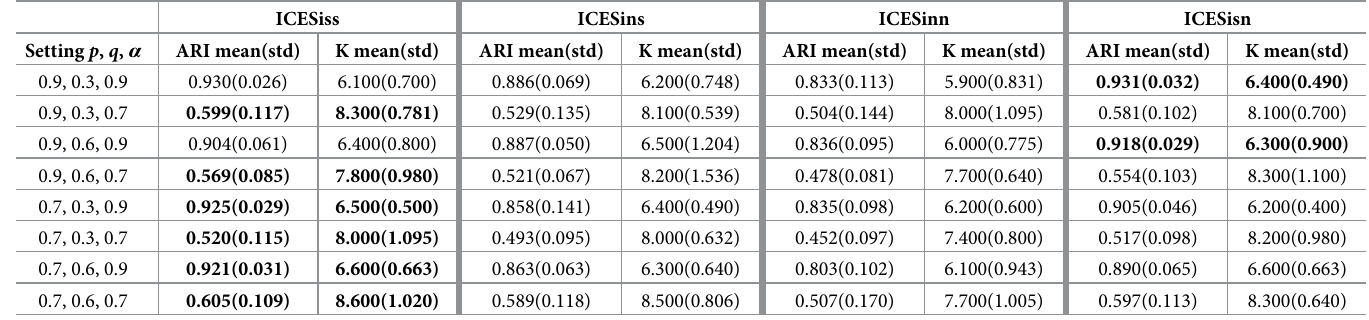
The best results are highlighted in bold-face.